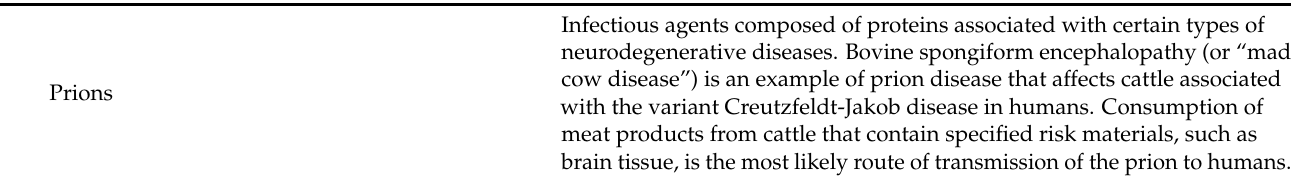
Table 1. Cont. Infectious agents composed of proteins associated with certain types of neurodegenerative diseases. Bovine spongiform encephalopathy (or “mad cow disease”) is an example of prion disease that affects cattle associated Prions with the variant Creutzfeldt-Jakob disease in humans. Consumption of meat products from cattle that contain specified risk materials, such as brain tissue, is the most likely route of transmission of the prion to